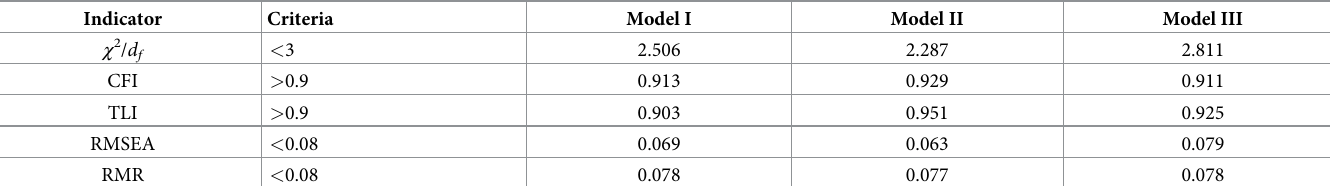
Table 7. Goodness-of-fit test